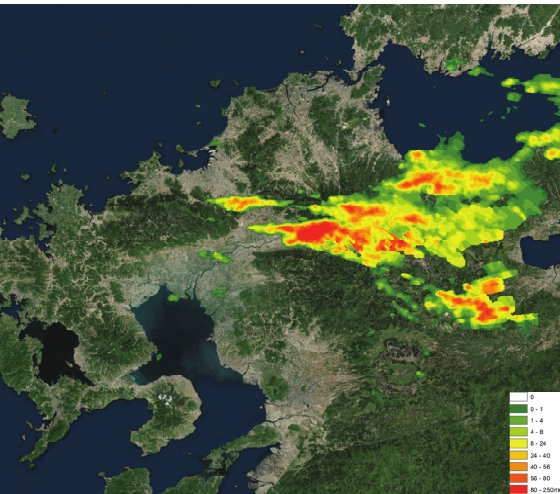
Figure 13. Result of inputting rainfall information of the X-band MP radar into GIS (2017.7.5 17:00).